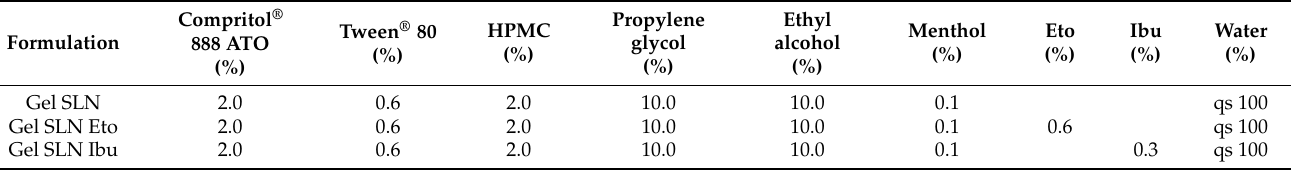
Table 1. Solid lipid nanoparticles (SLNs) hydroalcoholic gel compositions. Eto: etofenamate; Ibu: ibuprofen; Gel SLN: empty SLN hydrogel; Gel SLN Eto: etofenamate-loaded SLN hydrogel; Gel SLN Ibu: ibuprofen-loaded SLN hydrogel. Compritol Formulation